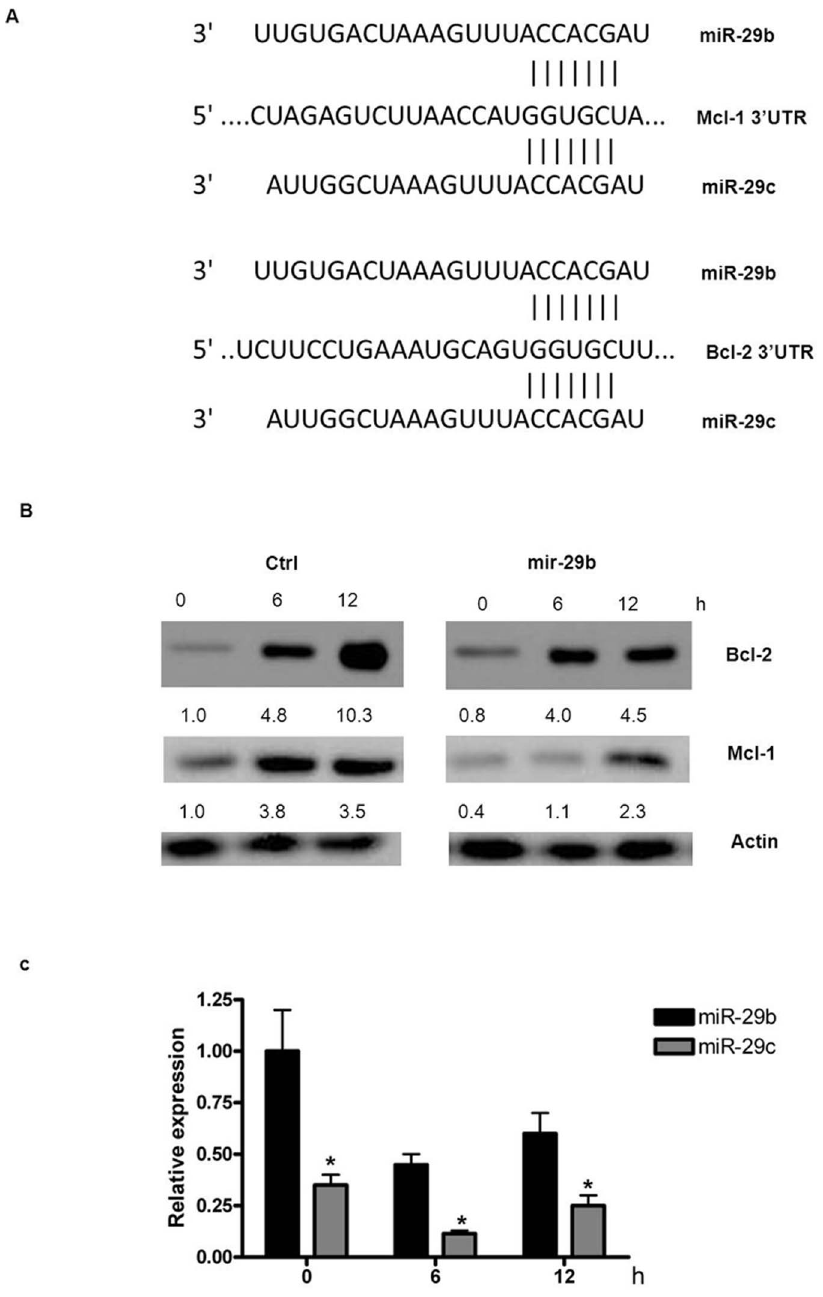
Figure 6. miR-29 promotes pDC apoptosis by targeting Mcl-1 and Bcl-2. (A) Target prediction. (B) miR-29 inhibited Mcl-1 and Bcl-2 expression. Primary pDCs were transfected with control (Ctrl) or miR-29b mimics and stimulated with CpG. The protein levels of Mcl-1 and Bcl-2 were analyzed by western blot. (C) Kinetics of miR-29b and miR-29c during CpG stimulation. The data are representative of at least 3 independent experiments, each using a different pDC preparation. Data are expressed as the mean 6 SD and were analyzed with a 2-tailed Student’s t test. *P , 0.05.